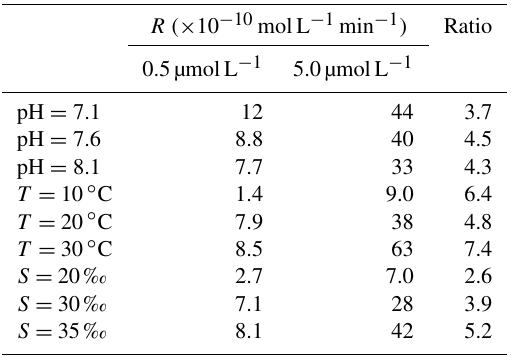
Table 2. The ratios of photoproduction rates ( R 5.0/ R 0.5) in the dif- ferent irradiation